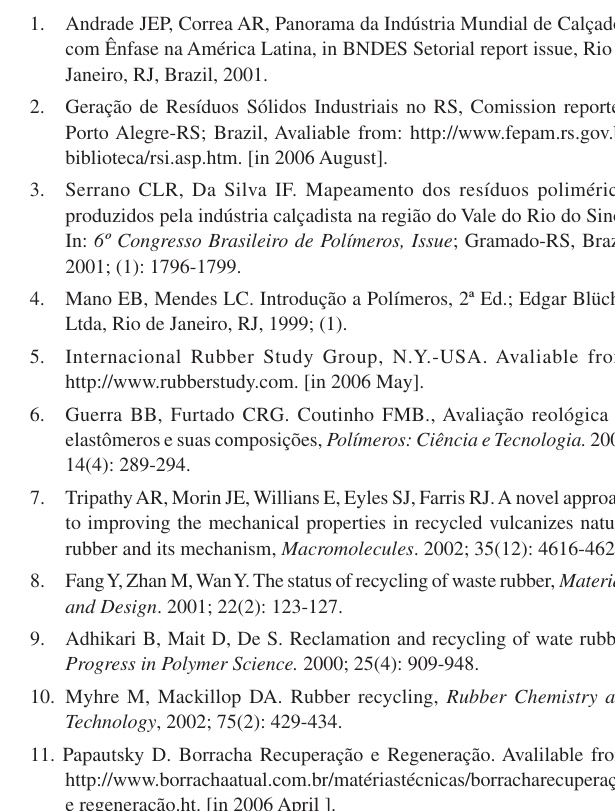
flow of 50 mL/min with a heating 2